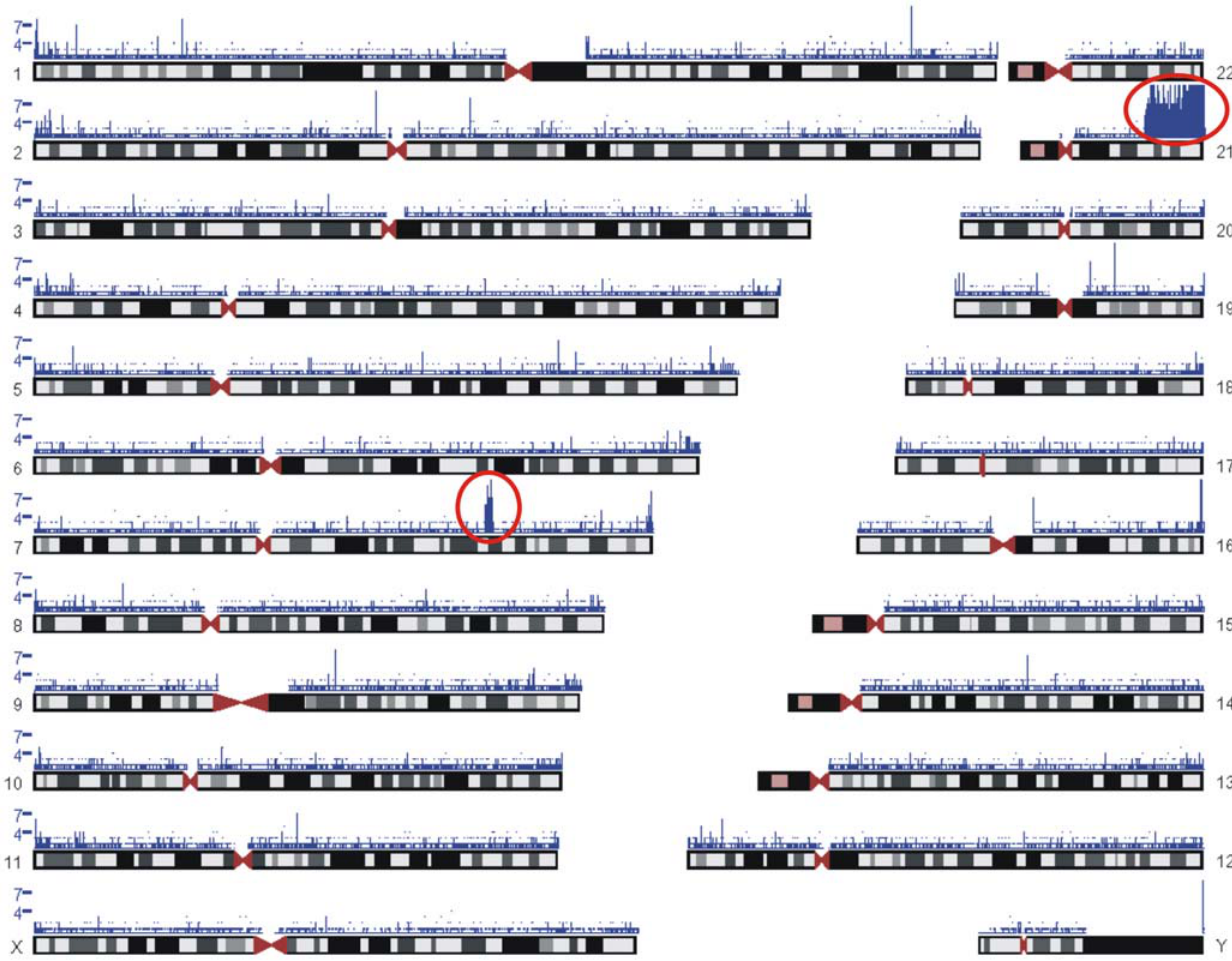
Figure 1. Enrichment of target regions. All sequencing tags that map uniquely to the reference human genome are displayed in blue. The height of peaks corresponds to the number of tags mapping to the same location. Red circles represent genomic areas plotted on the array. The image was generated using Genome Graphs (http://genome.ucsc.edu/cgi-bin/hgGenome).